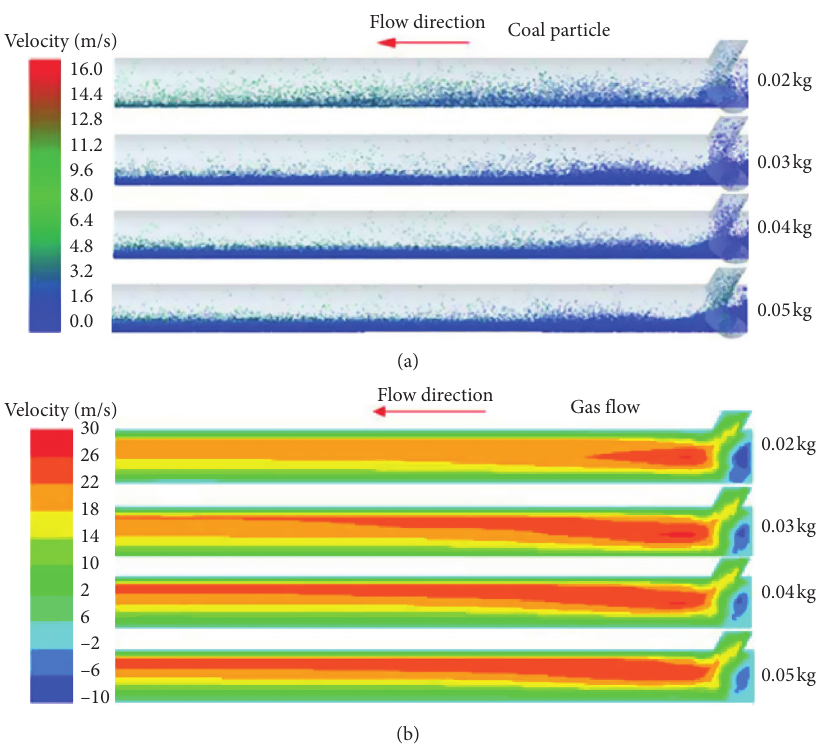
Figure 5: The coal-gas flow characteristic in drilling bit-rod integral structure 0 ∼ 0.5m under gas velocity of 20 m/s ( t � 3